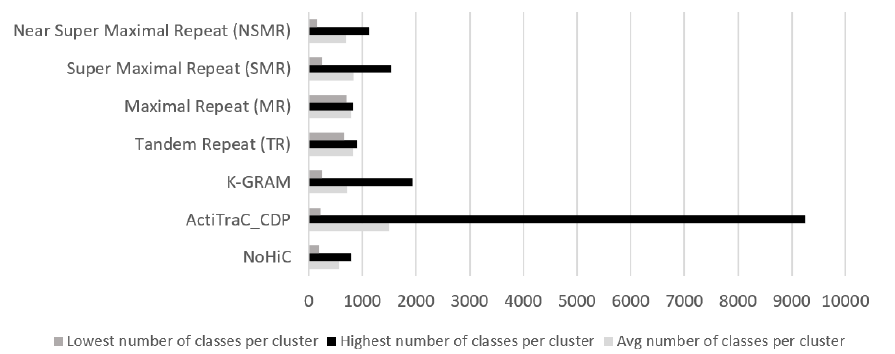
Figure 19. Comparison of techniques for the best average number of events classes per